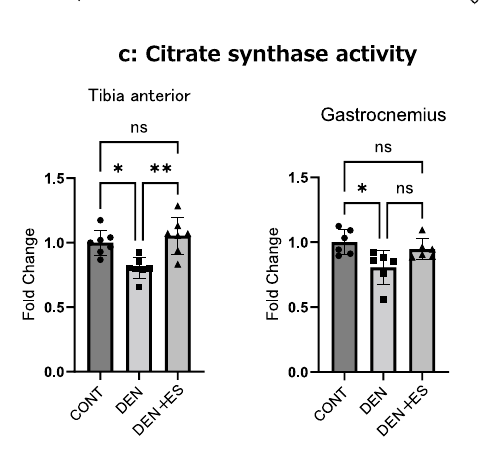
Figure 5. PGC-1α ( a ), COXIV ( b ), and CS activity ( c ) of TA and GAS after chronic belt electrode chronic stimulation. Mean ± SD. One-way ANOVA test was used to evaluate changes in PGC-1α and COXIV levels and CS activity in the lower limb muscles 24 h after chronic stimulation with a belt electrode. CONT unstimulated control group, DEN denervation muscle atrophy induced group, DEN + ES denervation muscle atrophy induced + electrical stimulation with belt electrode group; *p < 0.05, **p < 0.01, ***p < 0.001. All samples were derived from the same experiment and the gels/blots were processed in parallel. All blots are listed in the Supplementary